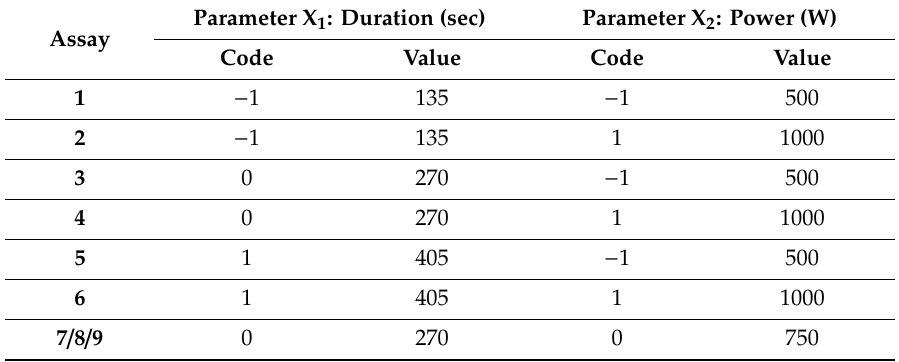
Table 8. Pretreatment conditions for the experimental design and results (mean of two measures from assays 1 to